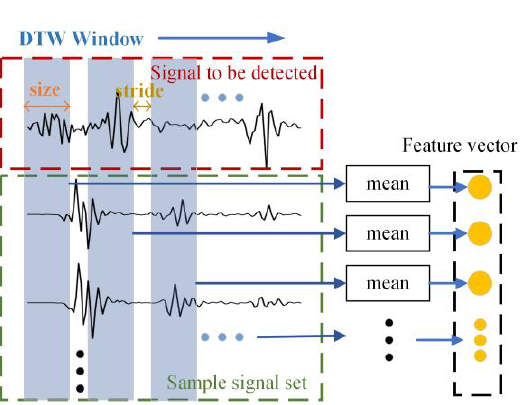
Figure 4. DTW similarity feature extraction.